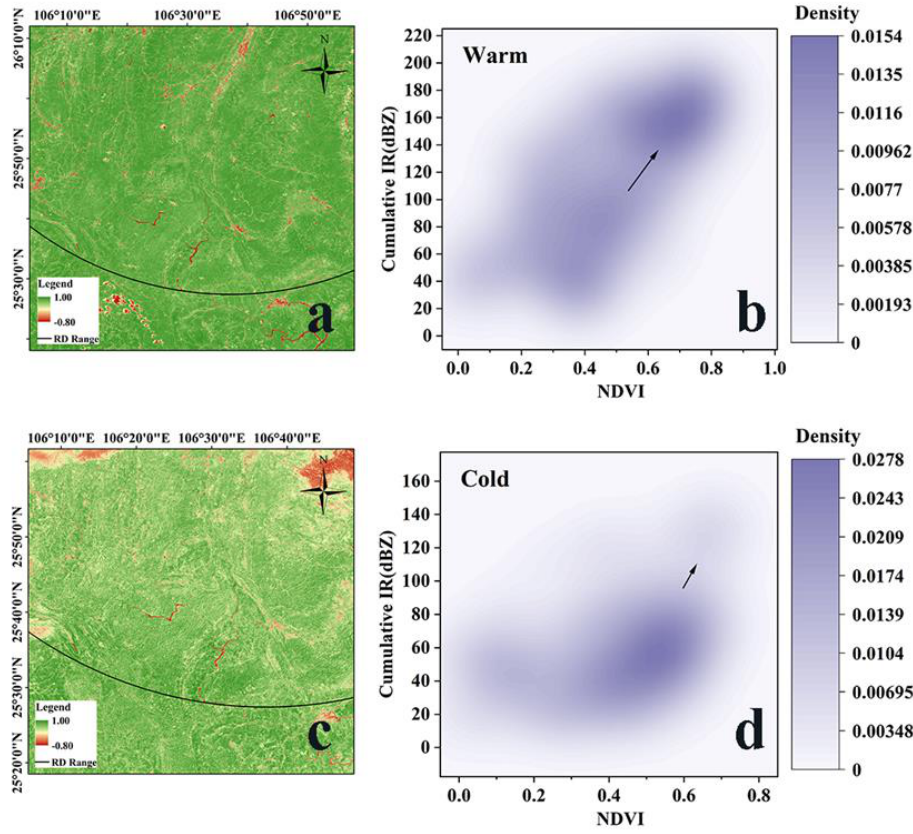
Figure 8. Distributions of the NDVI and KDE values in different seasons in the scanning region. ( a ) The NDVI on August 12, 2019, obtained from Sentinel satellite data; ( b ) KDE diagram generated from the NDVI and cumulative radar data in 2019; ( c ) the NDVI on 19 March 2020; ( d ) KDE diagram generated from the NDVI and cumulative radar data in 2020.